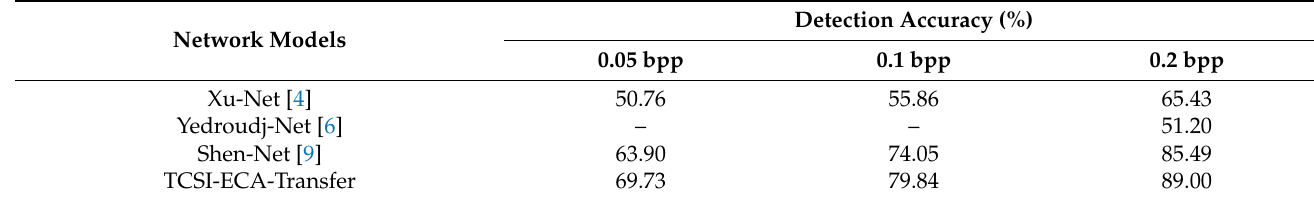
Table 5. Accuracy comparison with other models when using the WOW algorithm.